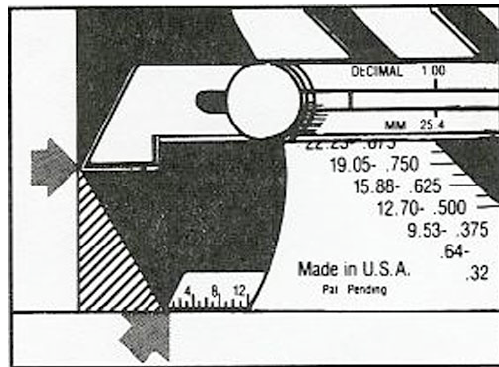
Fig. 7. Unequal-legged fillet gage [6]